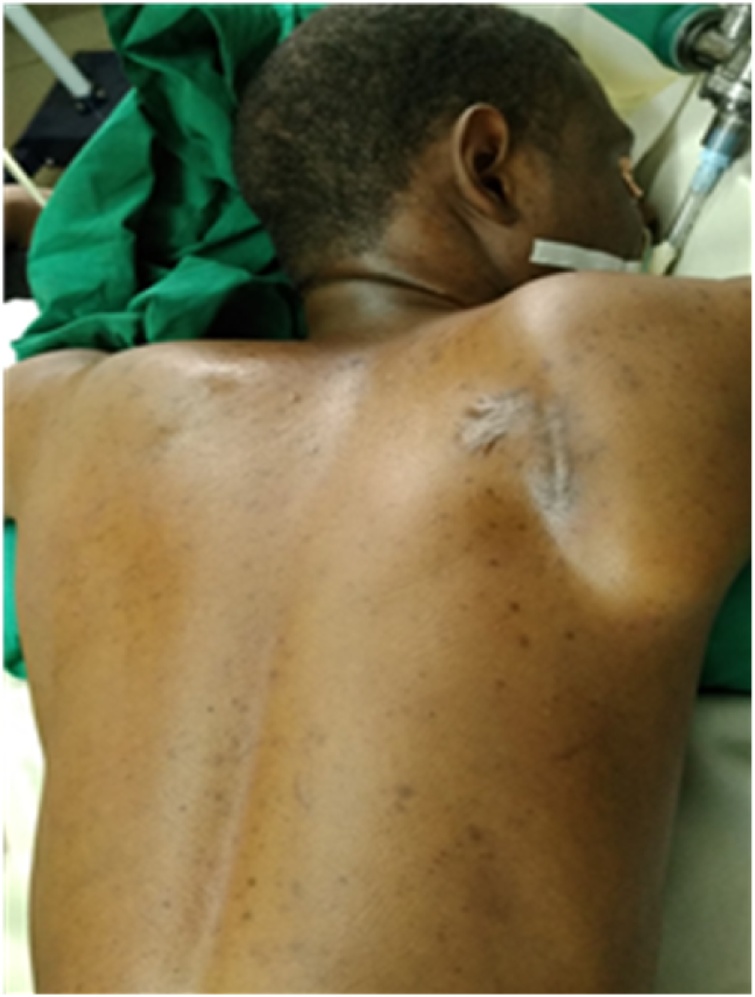
Patient positioning.